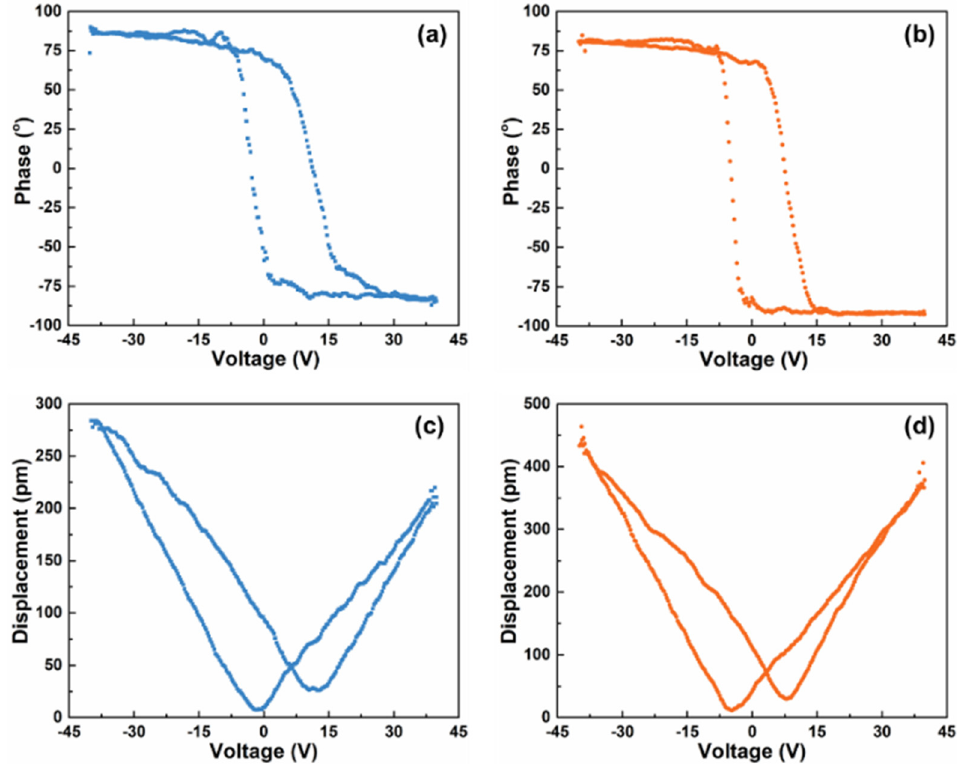
Figure 7. Out–of–plane phase–voltage and displacement–voltage butterfly hysteresis loops of the BNT–5.5BZ thin films annealed under different conditions: ( a , c ) “725 °C”, and ( b , d ) “650 °C + 725 °C” films.